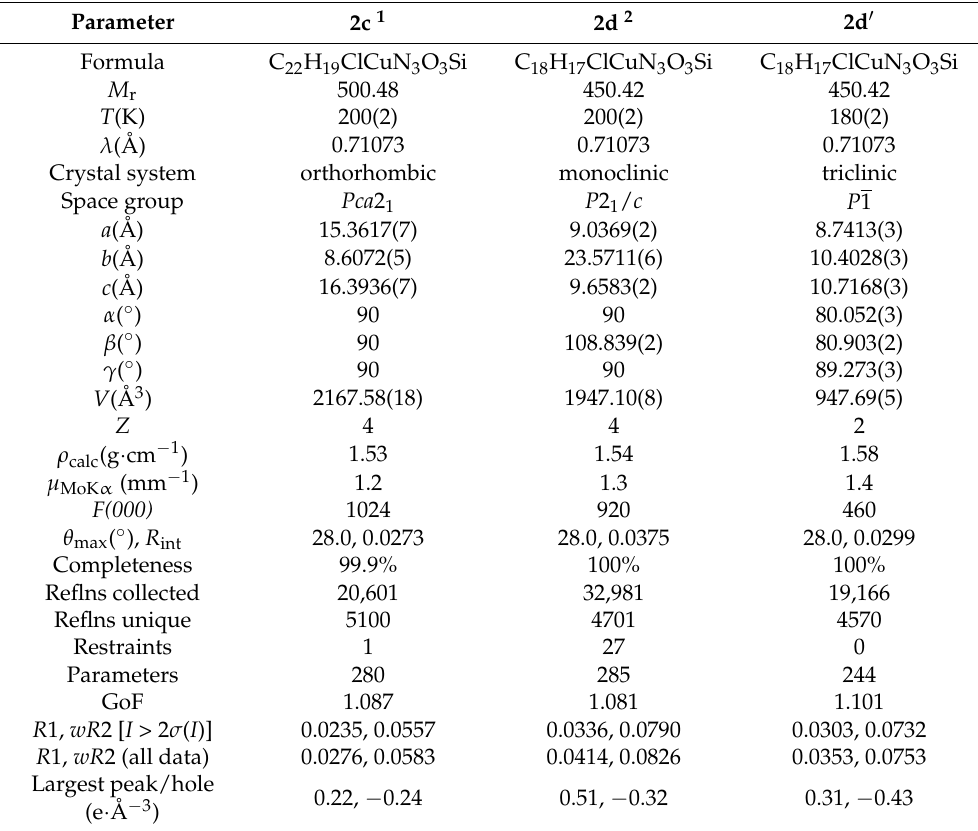
Table A2. Crystallographic data from data collection and refinement for 2c , 2d and 2d (cid:48) .